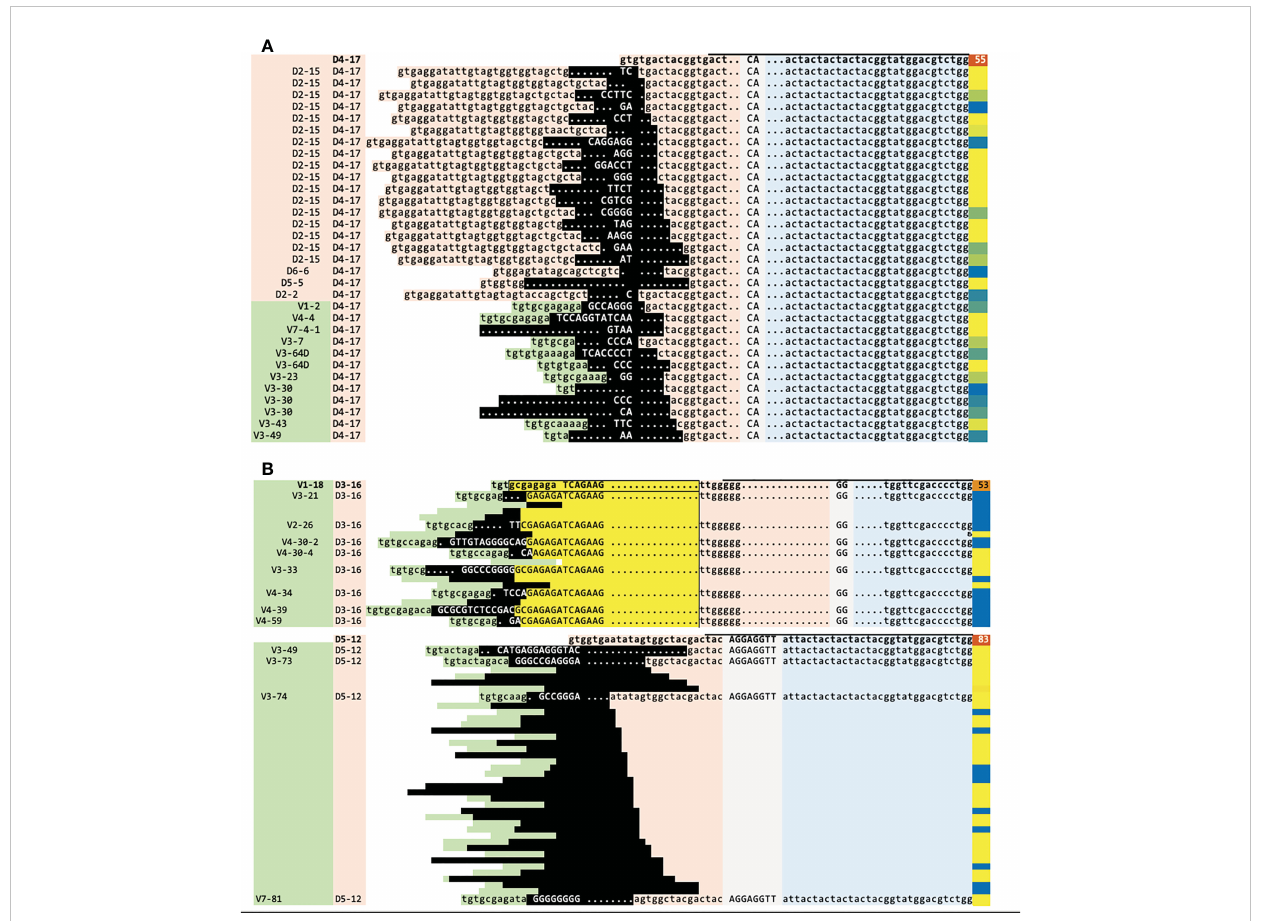
FIGURE 4 Sequence analysis of two cases illustrating the IGH clonal evolution mechanisms. (A) Case #61, ongoing D H -DJ H and V H -DJ H recombination on the same highly abundant DJ H root (55% of reads) (top row, in bold). (B) Case #126, one of two unique cases with DNJ-stems featuring both mechanisms, V H replacement and V H -DJ H recombination (V H replacement: top, V H -DJ H recombination: bottom). The mother clonotype of the V H replacement and the DJ H root of the V H -DJ H recombination are each shown on the top row and in bold. The DNJ-stem family members evolving by V H -DJ H use ‘ late ’ D-distal V H genes, which is uncommon for this mechanism (main text, Figure 5). Legend: green = V H , orange = D H , blue = J H , gray/uppercase = N regions, lowercase = germline, dots = deleted nucleotides, black = region affected by the recombination or replacement, yellow = region kept from the mother clonotype (on which the region is boxed), blue/yellow-to-orange (last column) = clonotype abundance in % reads, horizontal bar on top of fi rst sequence = DNJ-stem. Genes are indented in the 1st column to indicate locus order. A number of rows in (B) are ‘ squeezed ’ and their V H and D H assignment and nucleotide sequences are hidden for space and